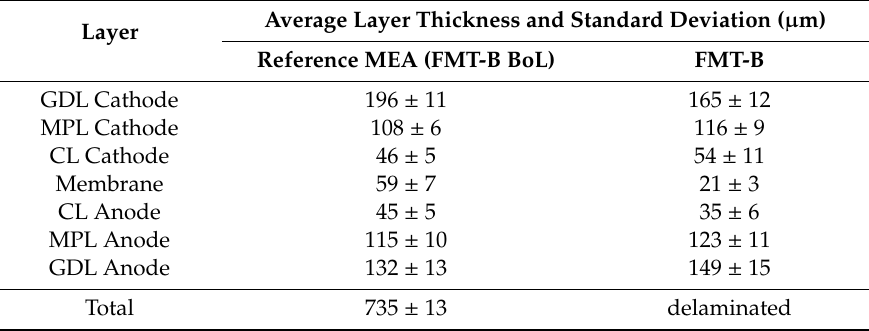
Table 4. Average layer thicknesses of FMT-B BoL and FMT-B determined by